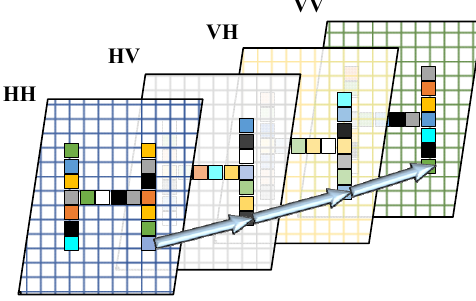
Figure 5. Distribution of scattered points in each channel. The four pictures represent the images in the four polarization channels, respectively. The pattern in the shape of letter ‘H’ is composed of 18 scattering points. Different colors of scattering points represent different amplitude values. Three arrows connect four scattering points, which correspond to the same position in the image. The schematic diagram shows that the theoretical distribution of scattering points in four polarization channels is